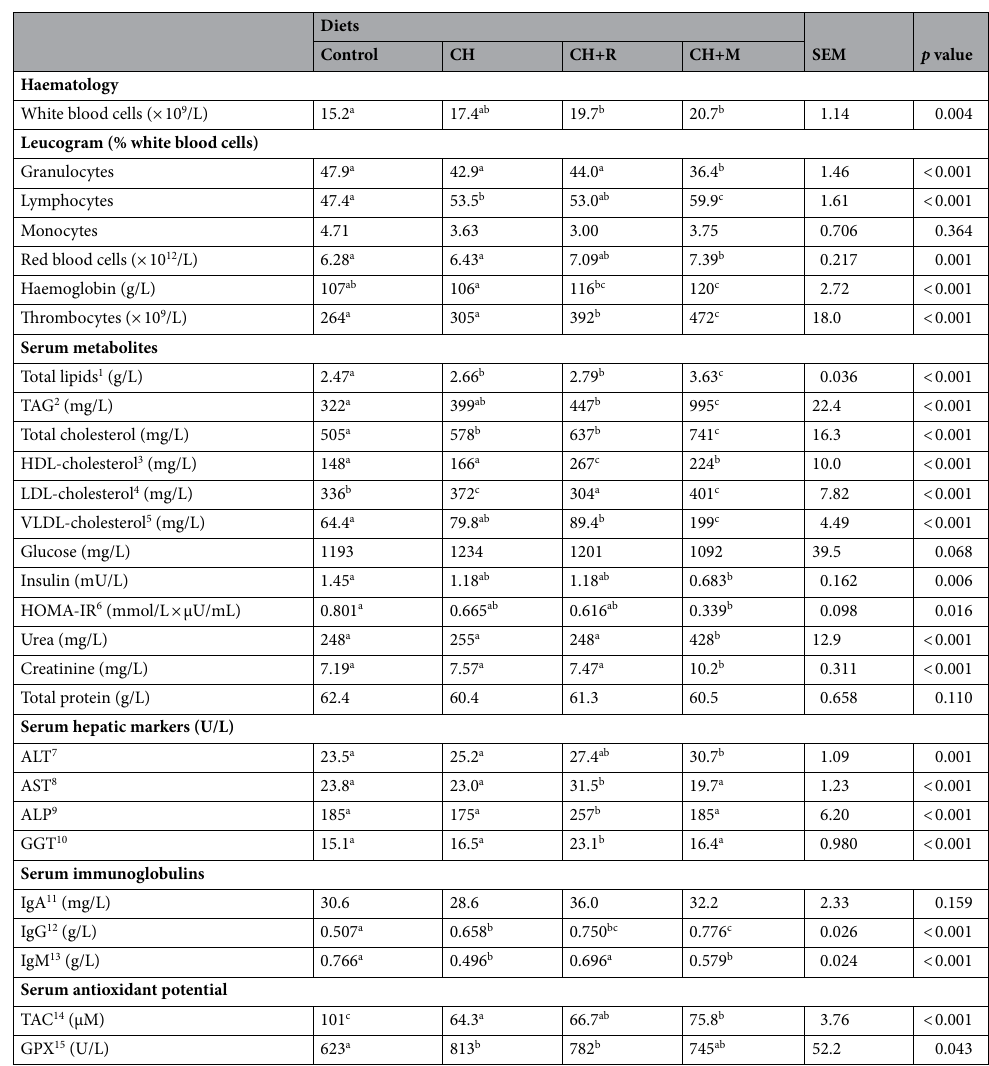
Table 1. Influence of experimental diets on blood parameters of piglets. Dietary treatments: Control— control diet; CH—5% Chlorella vulgaris diet; CH+R—5% Chlorella vulgaris diet supplemented with 0.005% Rovabio Excel AP; CH+M—5% Chlorella vulgaris diet supplemented with 0.01% enzymatic mixture. 1 Total lipids = [total cholesterol] × 1.12 + [TAG] × 1.33 + 148. 2 TAG—triacylglycerols. 3